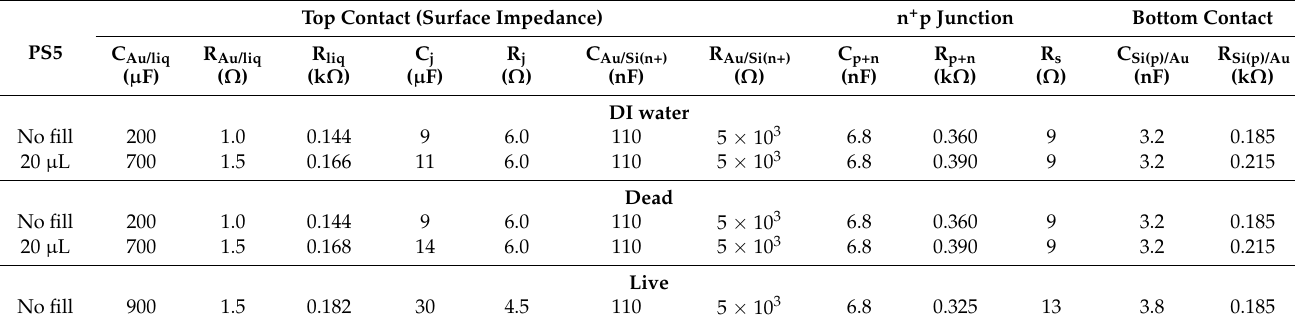
Table A1. Modeled parameters of the equivalent circuit (Figure 6a) of the three 1 × 1 cm 2 large PS5 impedance chips used for the investigation of adding 1, 2, 3, 4, and 5 µ L liquid with DI Water, with dead cells and with live cells before filling (No Fill) and after filling with 20 µ L DI water. Top Contact (Surface Impedance) n + p Junction Bottom Contact PS5 C Au/liq ( µ F)